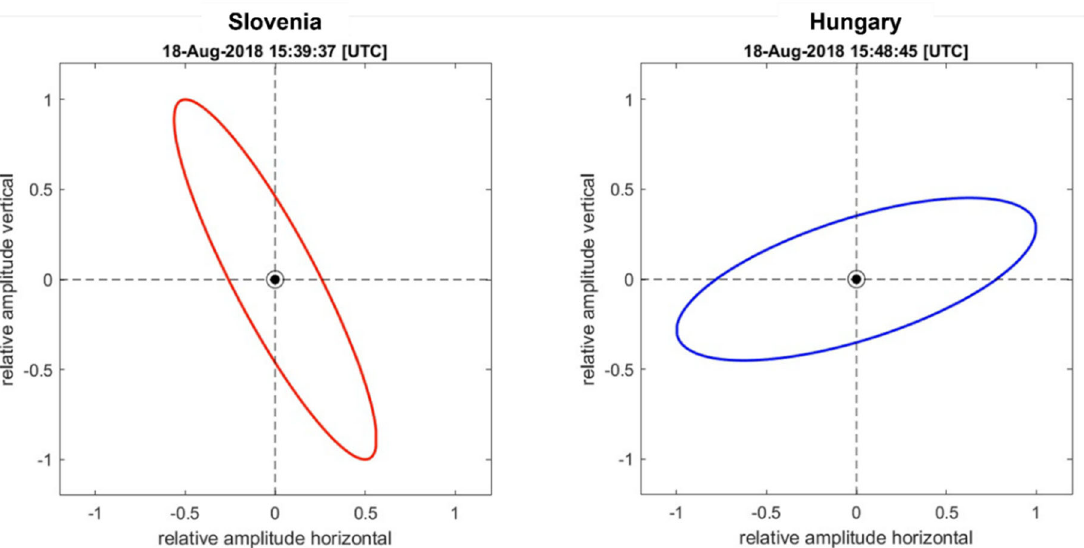
Figure 13. Illustrative snapshots from Supplementary Video S1 ( left ) and Supplementary Video S2 ( right ), showing the measured normalized polarization ellipse for the Slovenia and Hungary beacons respectively. Blue = right ‐ hand sense of rotation, red = left ‐ hand sense of rotation.